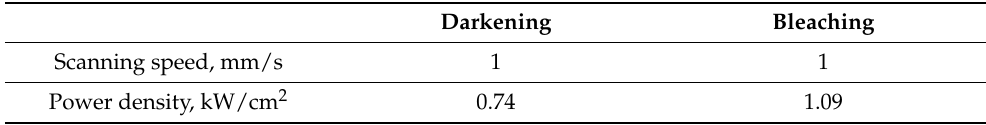
Table 1. Scanning modes with continuous NUV